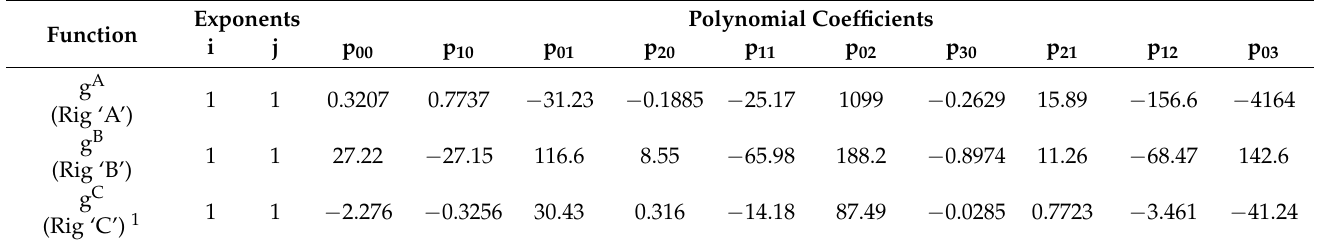
Table 3. Coefficient values for g(U a , U w ) correlation functions, Equation (13).